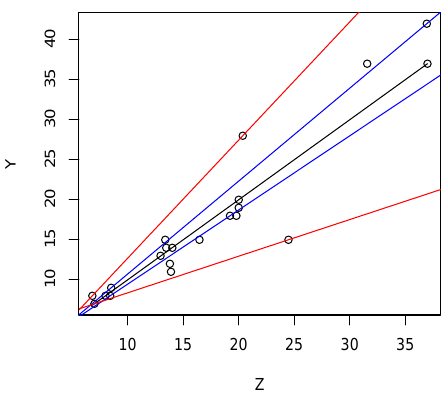
Figure 16: BBP in option 3 obtained from linear quantile regression for a real data set with three explanatory variables X 1 , X 2 , X 3 and a response variable Y . The variable Z given in (4.2) represents the linear median regression expression ob- tained from X 1 , X 2 , X 3